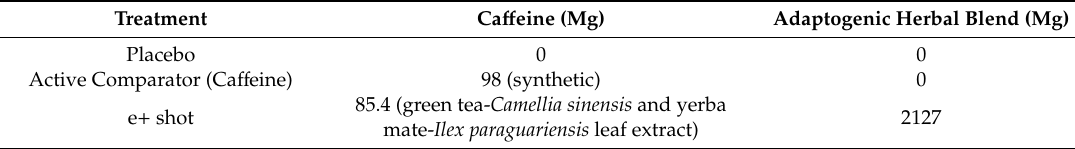
Table 2. Comparison of Study Product